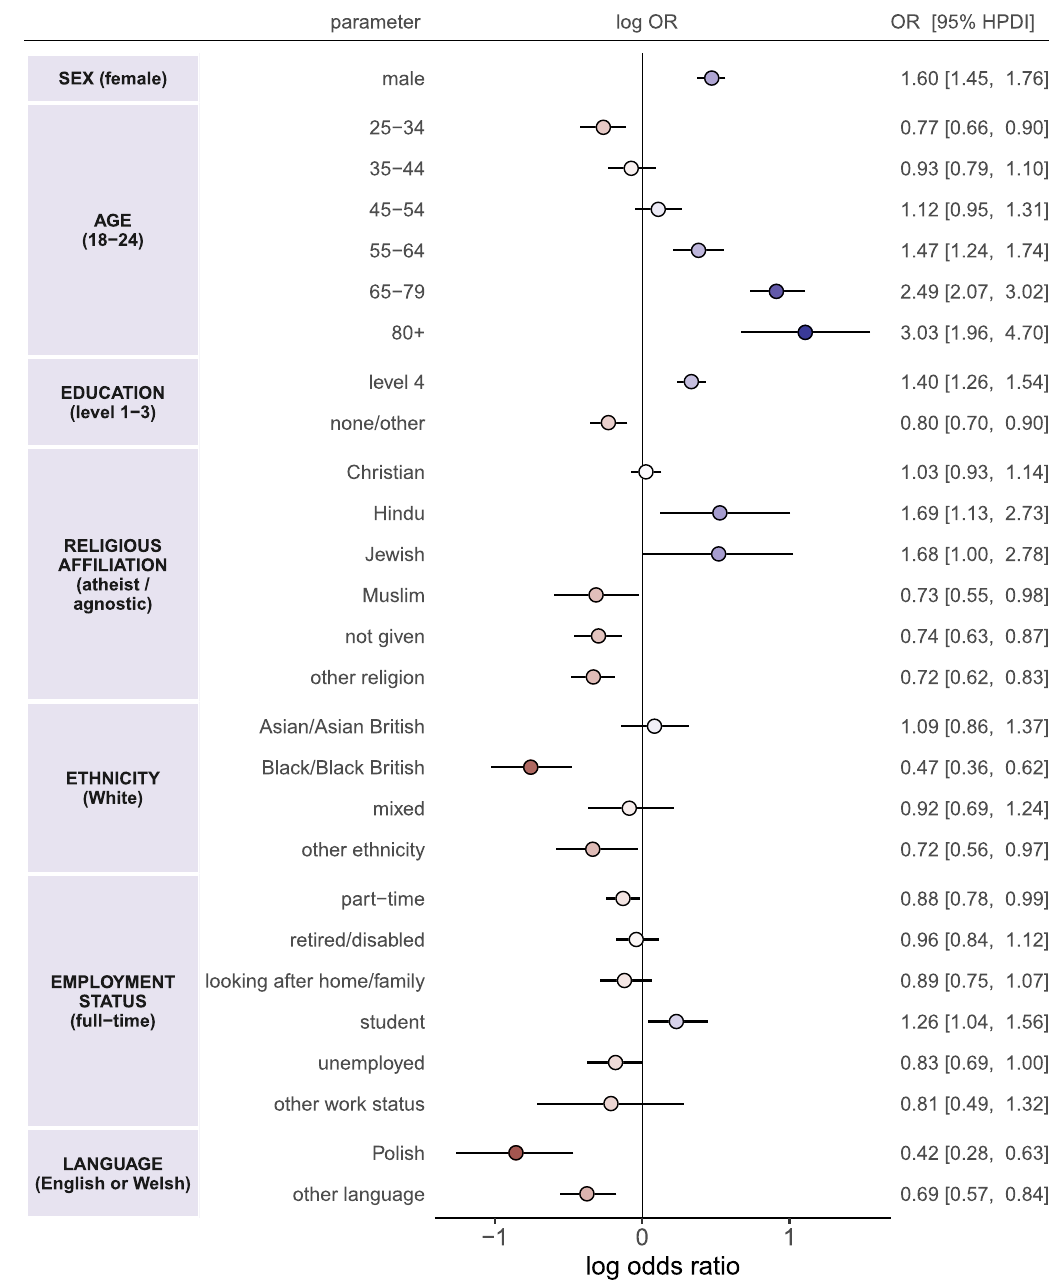
Figure 4. Socio-demographic determinants of intent to accept a COVID-19 vaccine. Multilevel regression fixed-effect parameter log odds ratios are plotted with corresponding 95% HPDIs. These log odds ratios are coloured by effect magnitude and direction, where blues (reds) signify that the group is more (less) likely than the baseline group to accept a COVID-19 vaccine. The darker the colour the stronger the association. For each factor, the baseline group is provided in parentheses on the left. Odds ratios with 95% HPDIs are shown on the right for each